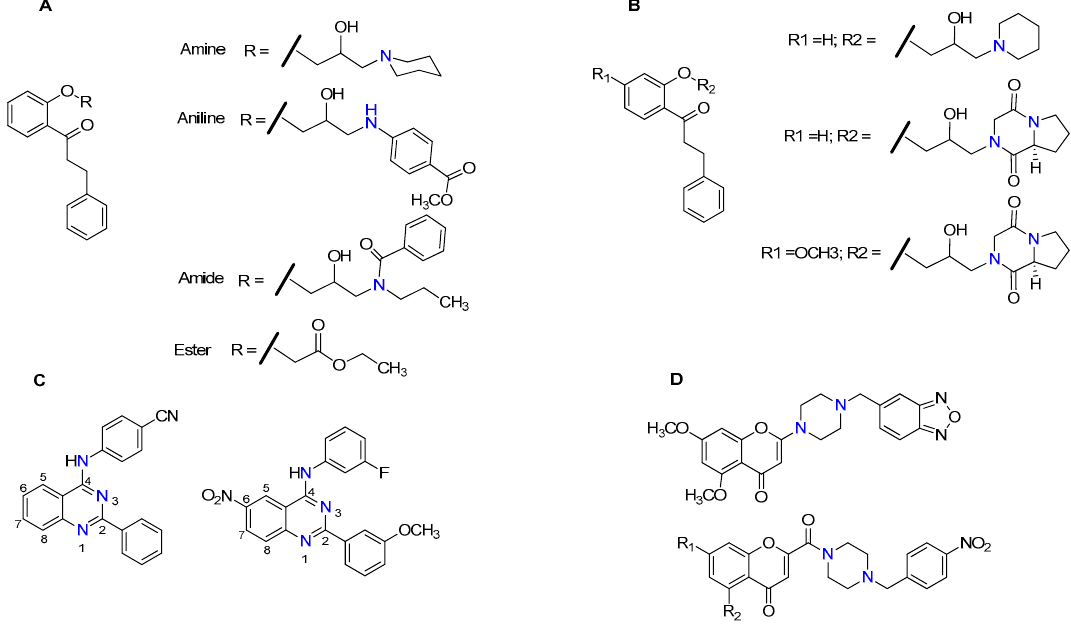
Figure 5. Examples of propafenone ( A ) prepared by Heckler et.al. [87] and ( B ) prepared by Cramer et al. [88]) quinazolide ( C ) and chromone ( D ) derivatives bearing nitrogen substituents.